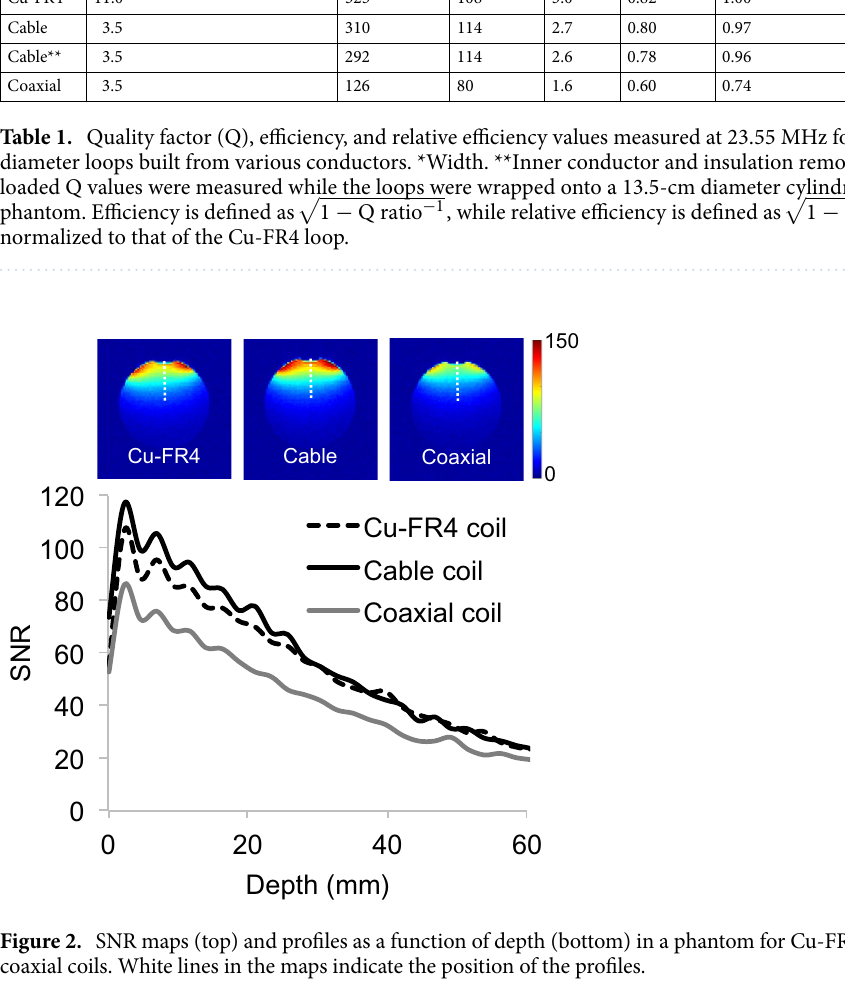
Figure 2. SNR maps (top) and profiles as a function of depth (bottom) in a phantom for Cu-FR4, cable, and coaxial coils. White lines in the maps indicate the position of the